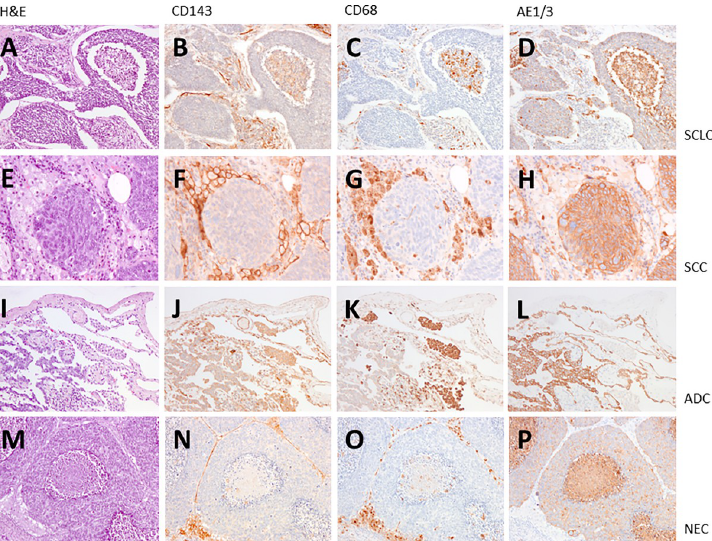
Fig 1. ACE expression in lung cancer. We performed immunostaining on the lung cancer specimens with anti-ACE mAbs CG2. We have analyzed 3 cases of SCLC (small cell lung cancer; pictures A-D), 9 cases of NSCLC (non-small lung cancer), here 3 squamous cell carcinoma (SCC; pictures E-H), 3 adenocarcinoma (ADC; pictures I-L) and 3 neuroendocrine carcinoma (NEC; pictures M-P). ACE expression and localization is shown by brown color. Compared to anti-CD68 (macrophages; pictures C, G, K, O) and AE1/3 (cancer cells; pictures D, H, L, P) ACE is expressed strongly in macrophages and endothelial cells of the tumor vascularization in all types of lung cancer analyzed (pictures B, F, J, N). A weak expression of ACE in cancer cells was only found in adenocarcinoma (picture J). ACE was not detected in cancer cells of SCLC, SCC and NEC (pictures B, F, N). A, E, I, M: H&E; B, F, J, N: CD143 (ACE); C, G, K, O: CD68; D, H, L, P: AE1/3. Magnification x100 (A-D, I-L, M-P), x200 (E-H).